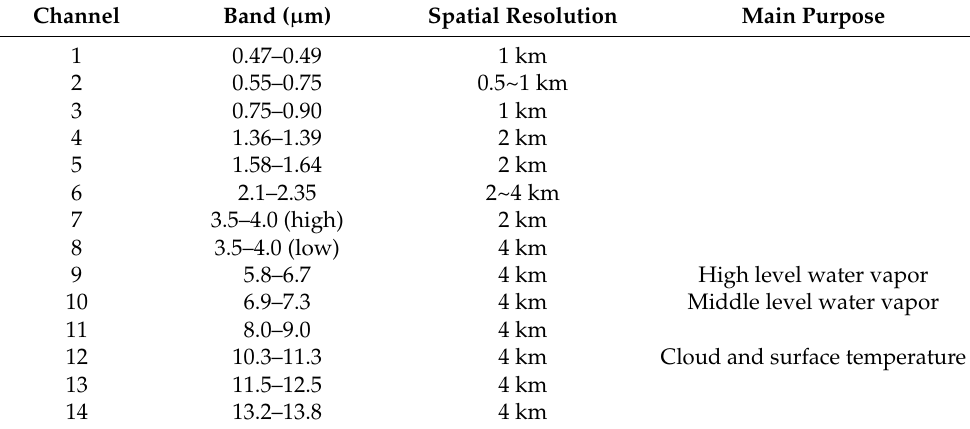
Table 1. Characteristics of the AGRI instrument.